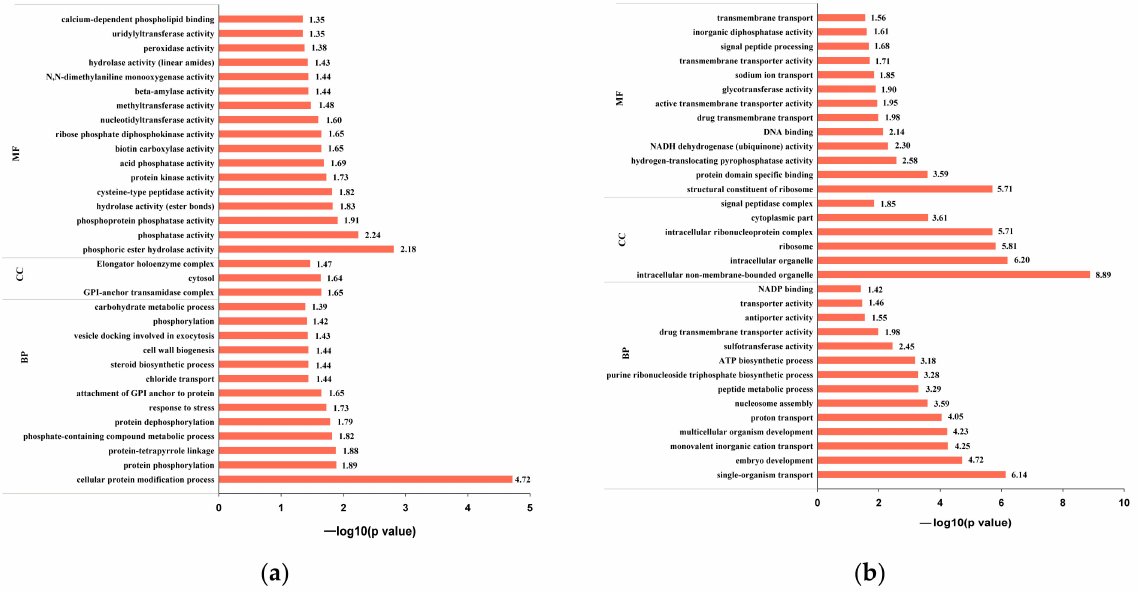
Figure 4. GO analysis of DEPs in JZ ( a ) and NJ ( b